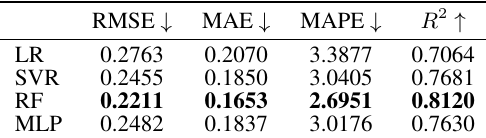
Table 2. Results of using different regression models with input of ALL features.